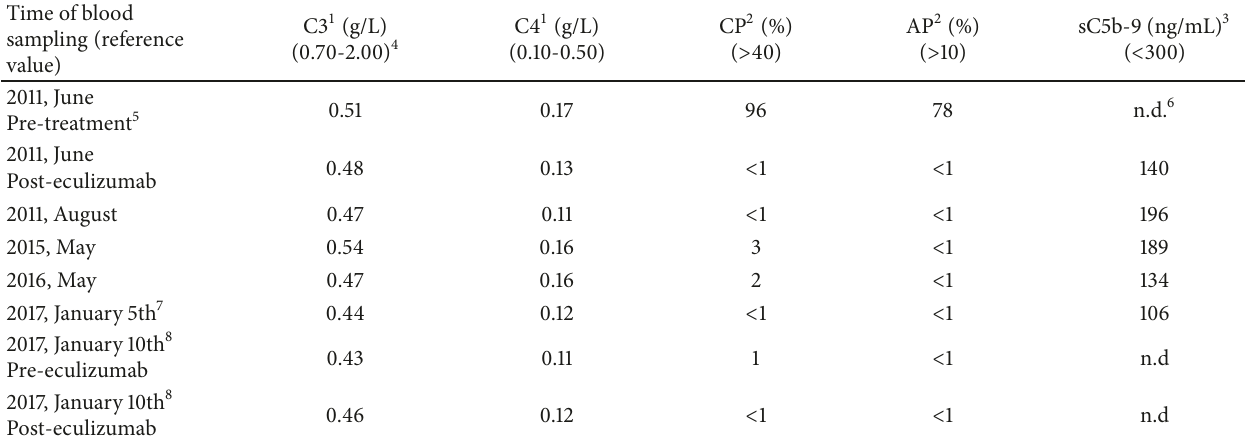
Table 1: Complement analyses of the aHUS patient presented in this